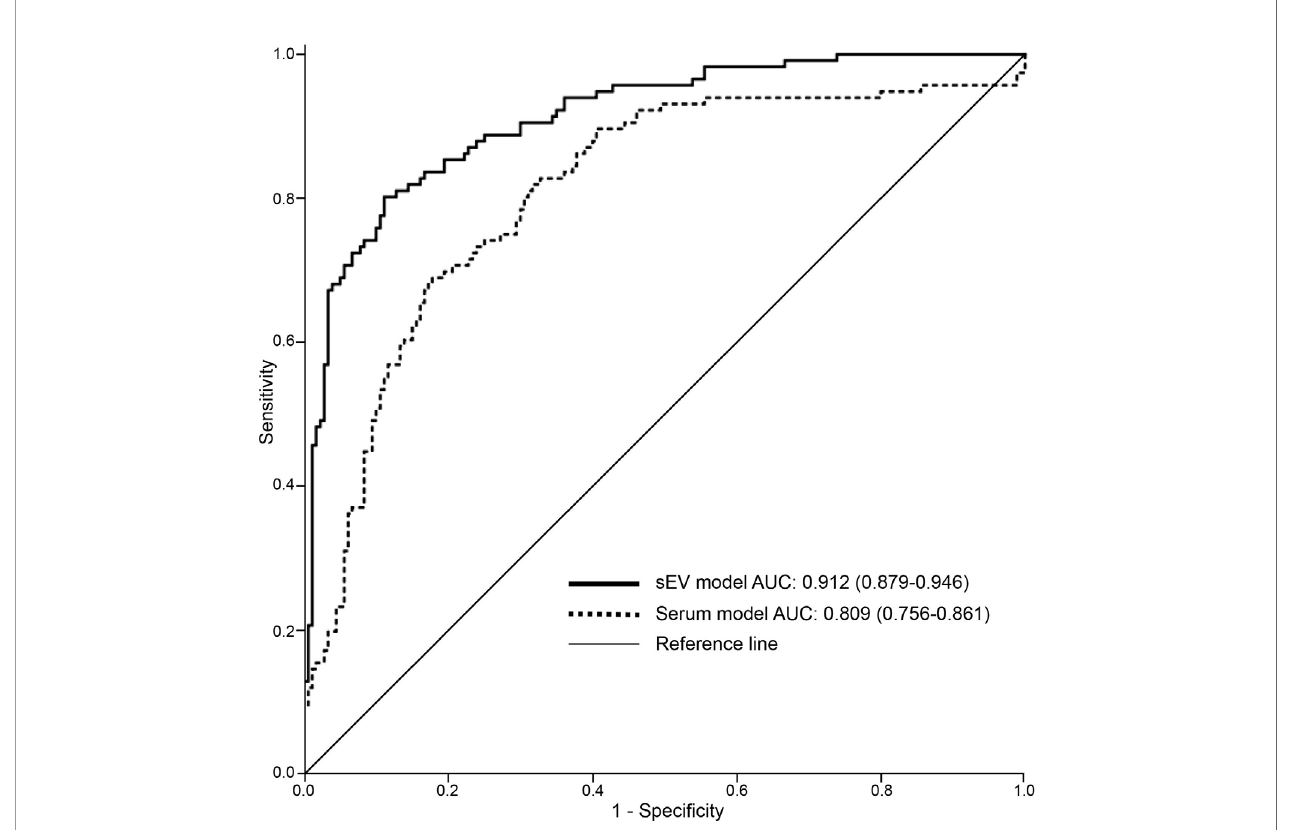
FIGURE 1 | Receiver operating characteristic (ROC) analysis for identifying EOC using serum sEV or serum marker panel models. The serum sEV model consists of serum sEV levels of C5a, CA125, and HE4. Serum model includes serum level of CA125 and HE4